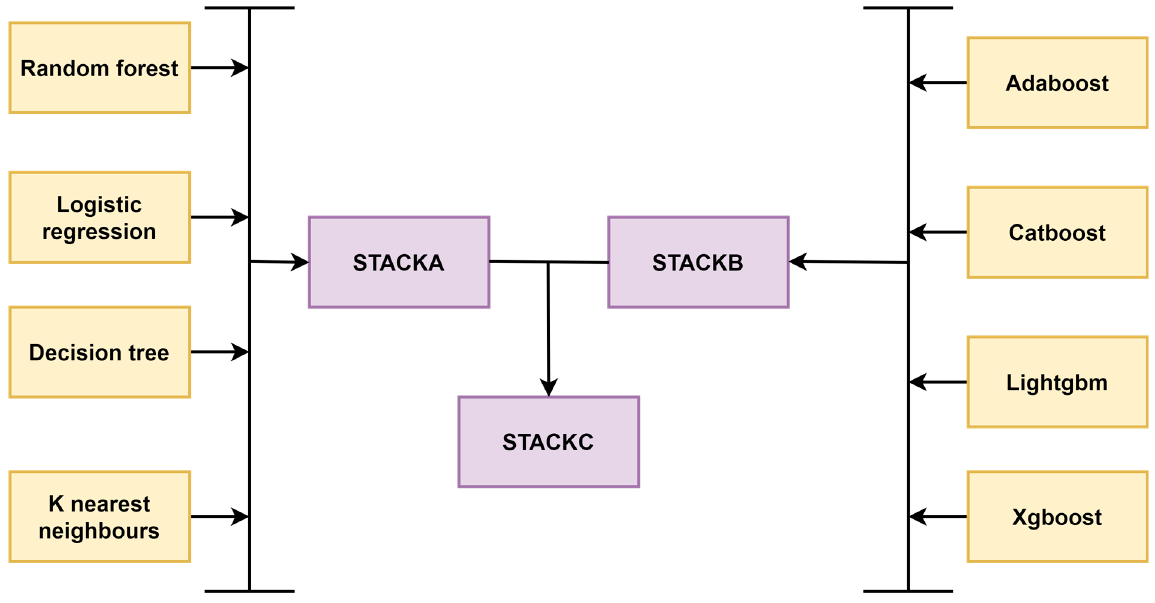
Figure 5. Custom stacked architecture to predict COVID-19 from other ILI patients.